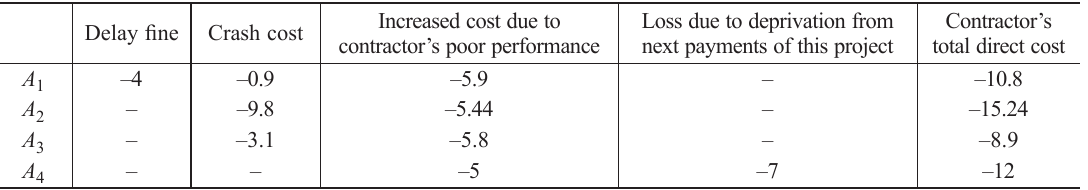
Table 4.B. Elements consisting contractor’s costs for different alternatives (in million $)